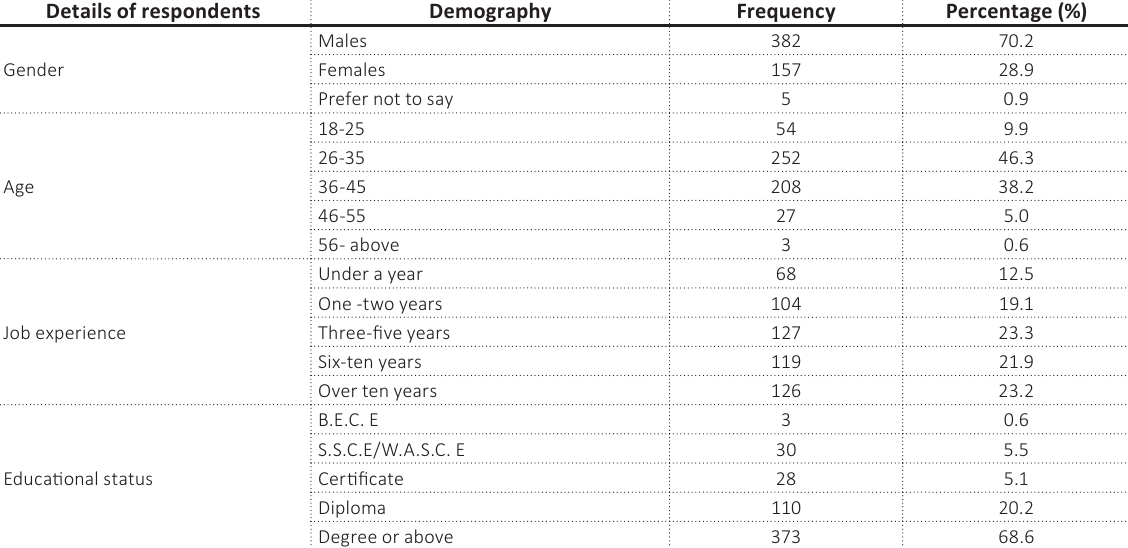
Table 1. Demography and characteristics of the respondents